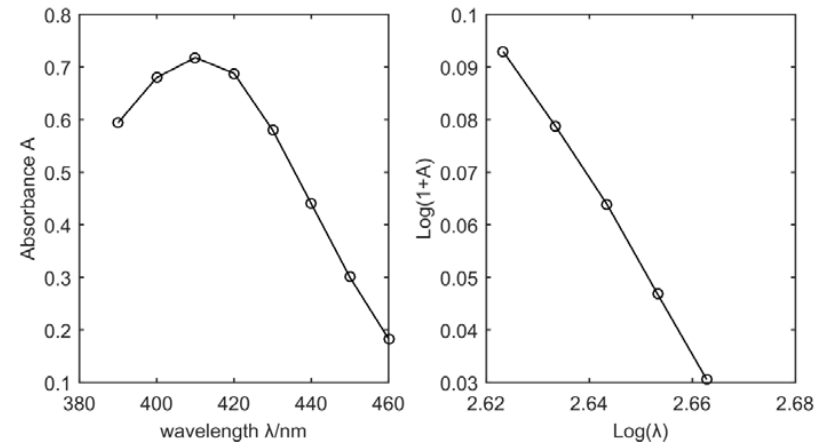
Figure 3. Absorption spectra of the color solution and the Log(1 + A) − Log( λ ) curve.